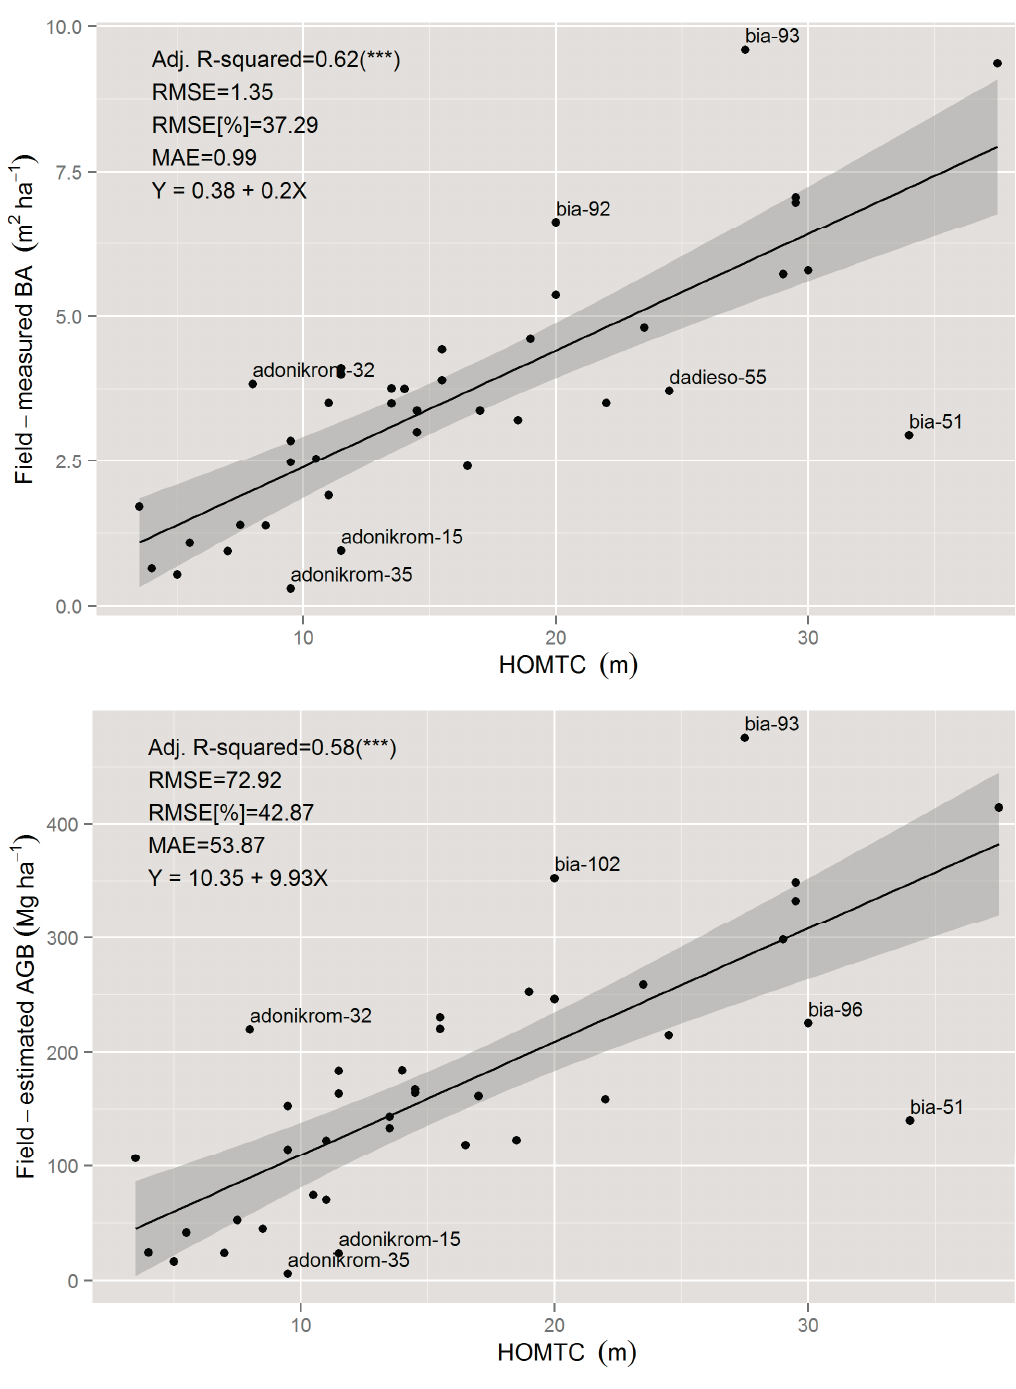
Figure 8. Predicted vs. reference values for AGB and BA from the HOMTC plot-based metric. Bands represent the 95% confidence